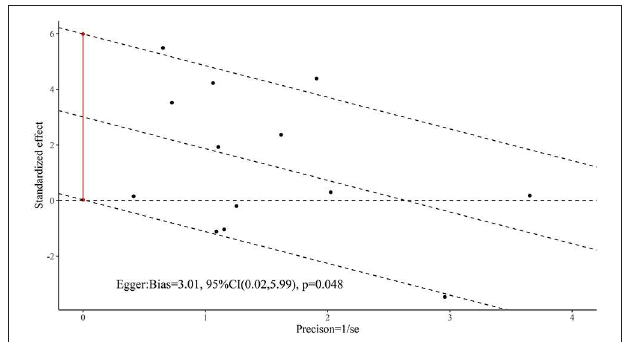
FIGURE 4 | The Egger test result for general cognitive function of acupuncture vs. drug therapy in the medium term.